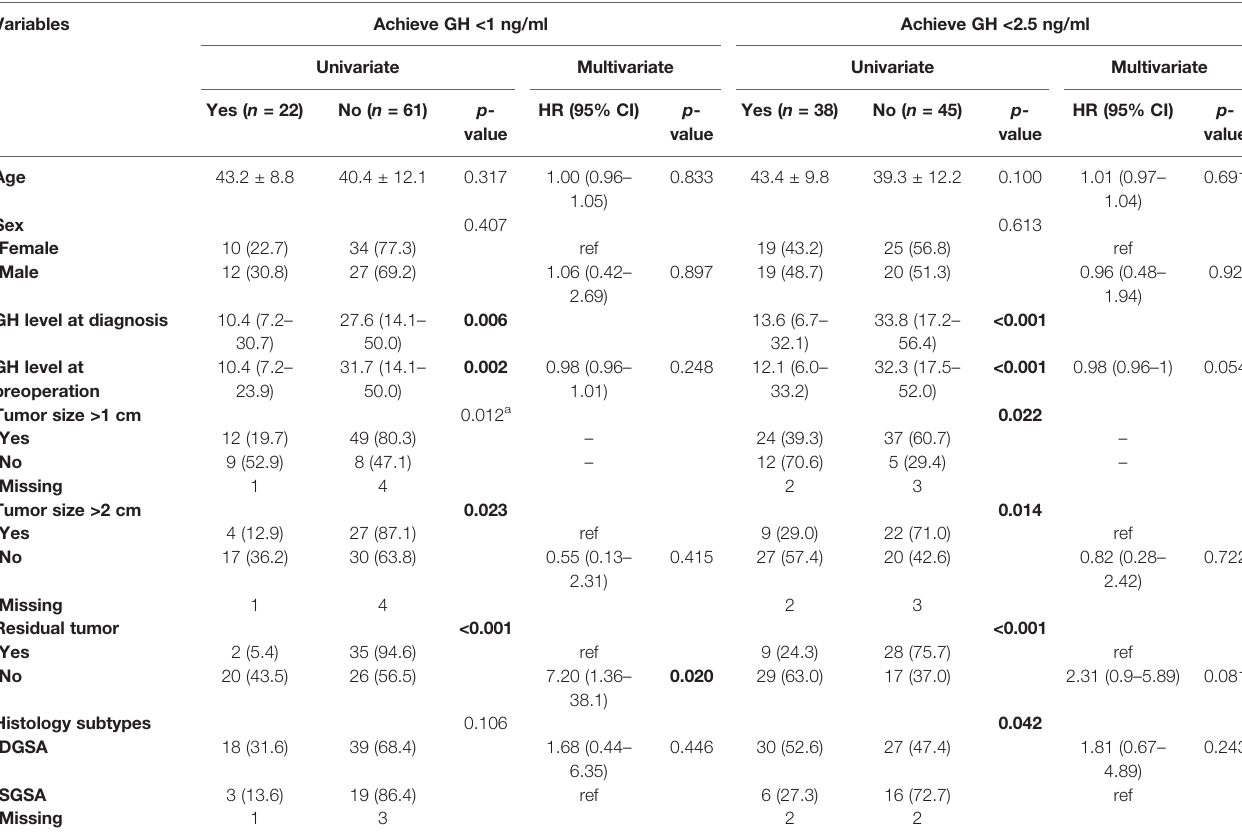
TABLE 3 | Factors associated with remission at 6 months after fi rst surgery in univariate and multivariate analyses.